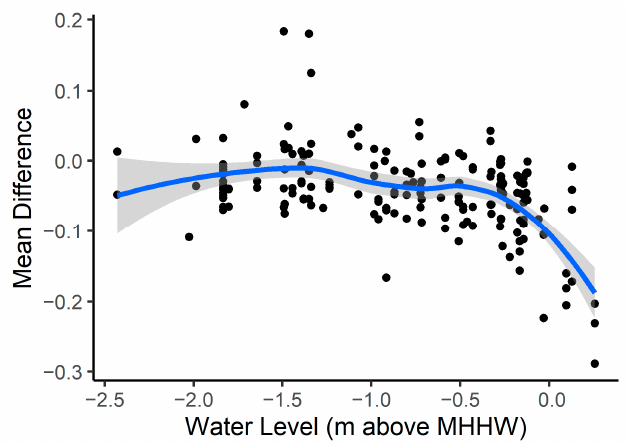
Figure A5. Model error (mean difference) versus water level (m) above MHHW. Mean difference is the predicted EVI minus 2019 observed Landsat EVI. We estimated the water level by finding the water level at the tide gauge closest to the study sites used for model development. We only calculated the mean difference versus water level for the 14 study areas used for model development. We found the mean difference versus water level for all the available 2019 Landsat images. We fit a smoothing trendline with standard error to better understand how mean difference is influenced by water level.